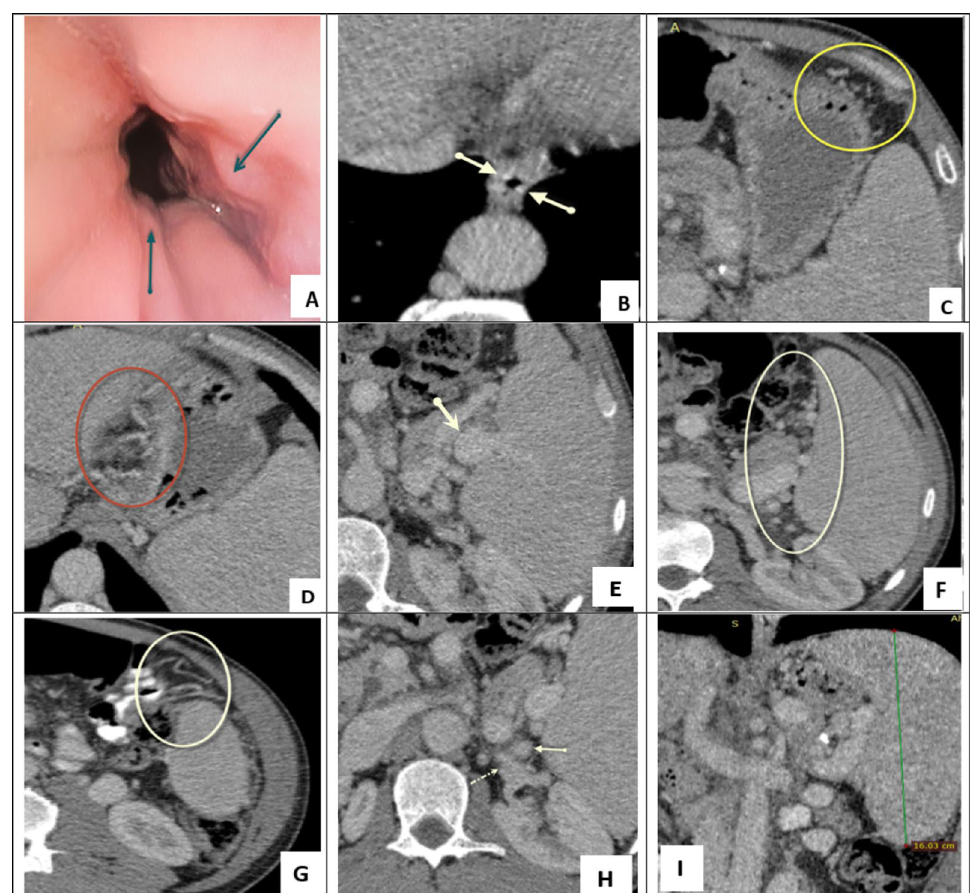
Fig. 6 A 55-year-old male patient with chronic liver disease and esophageal varices: A Upper GI endoscopy reveals 2 cords grade I (solid arrows). Axial CT shows the following; B 2 cords grade I (solid arrows), C , D Retrogastric (adventitial varices), E dilated and tortuous splenic vein (solid arrow), F hilar splenic varices (oval region). G Lower pole perisplenic varices (oval region). H Lienorenal shunt (solid arrow), left renal vein (dashed arrow). I Coronal CT demonstrates mild enlargement of the LS diameter of the spleen to 16